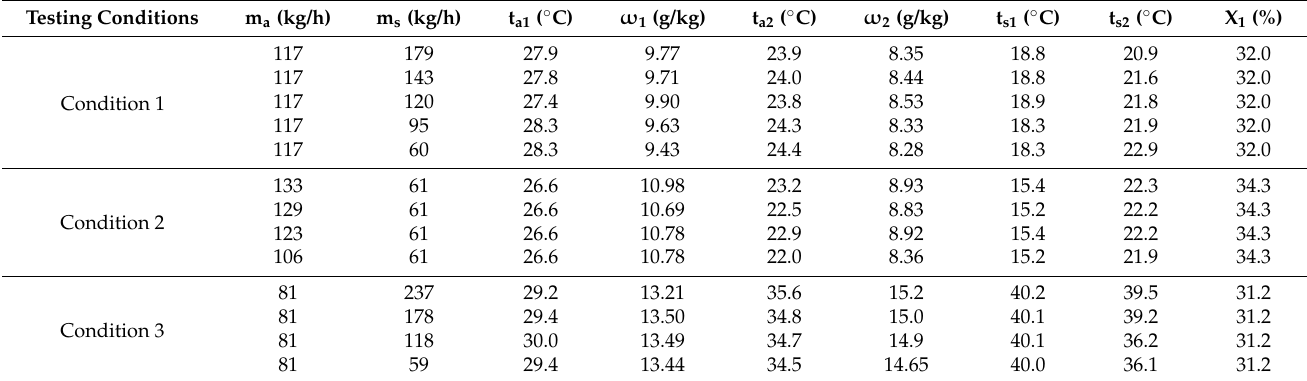
Table 2. A sample of experimental